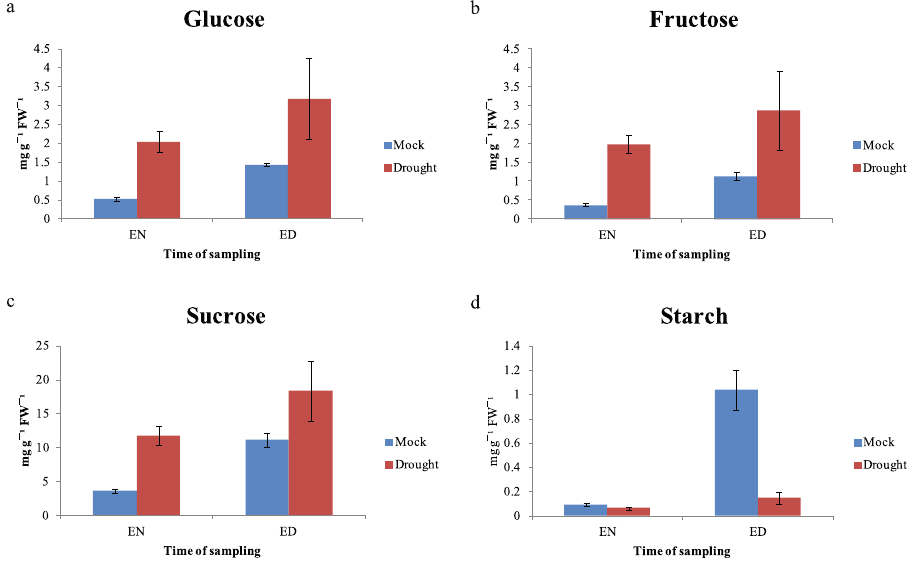
Figure 5. Diurnal alterations in soluble sugars and starch contents from rice leaves under drought stress. On Y axis: contents (mg g − 1 FW of sample) of a ) glucose; ( b ) fructose; ( c ) sucrose; and ( d ) starch. X-axis features time of sampling: EN, end of night; and ED, end of day. MOCK control, samples not subjected to stress treatment; Drought, samples from plants exposed to drought conditions. Error bars indicate standard errors of 3 replicates.